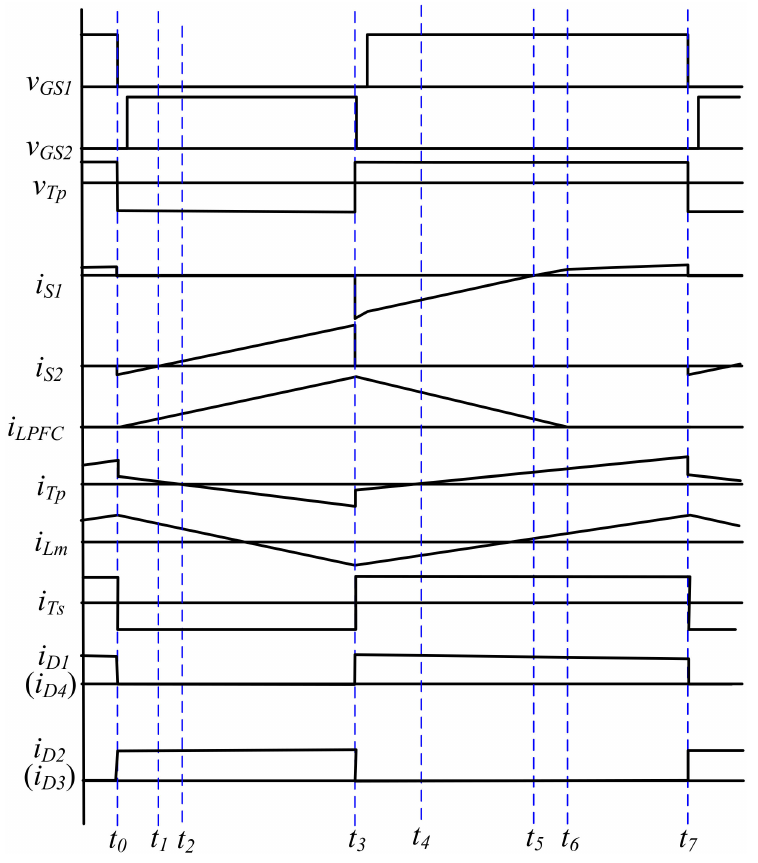
Figure 3. The theoretic waveforms of key